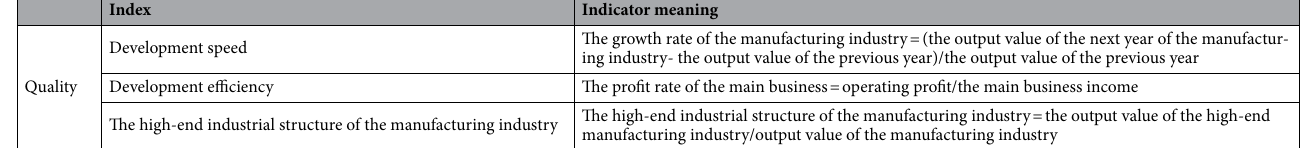
Table 1. Evaluation indicators for high-quality development of manufacturing